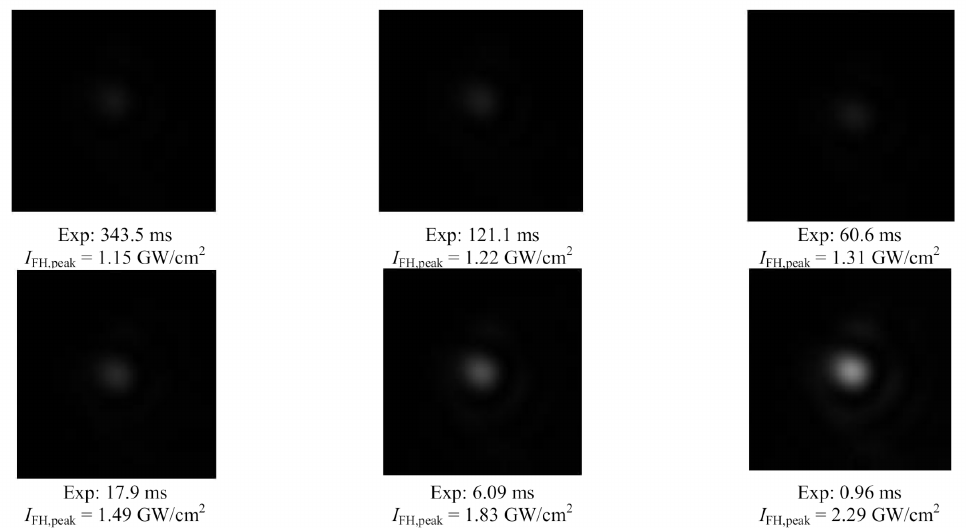
Figure 7. Images of the TH beam spot generated in GaN crystal, framed in a 200 px ∗ 200 px window at several peak intensities of the incident FH. The exposure times corresponding to the recordings are